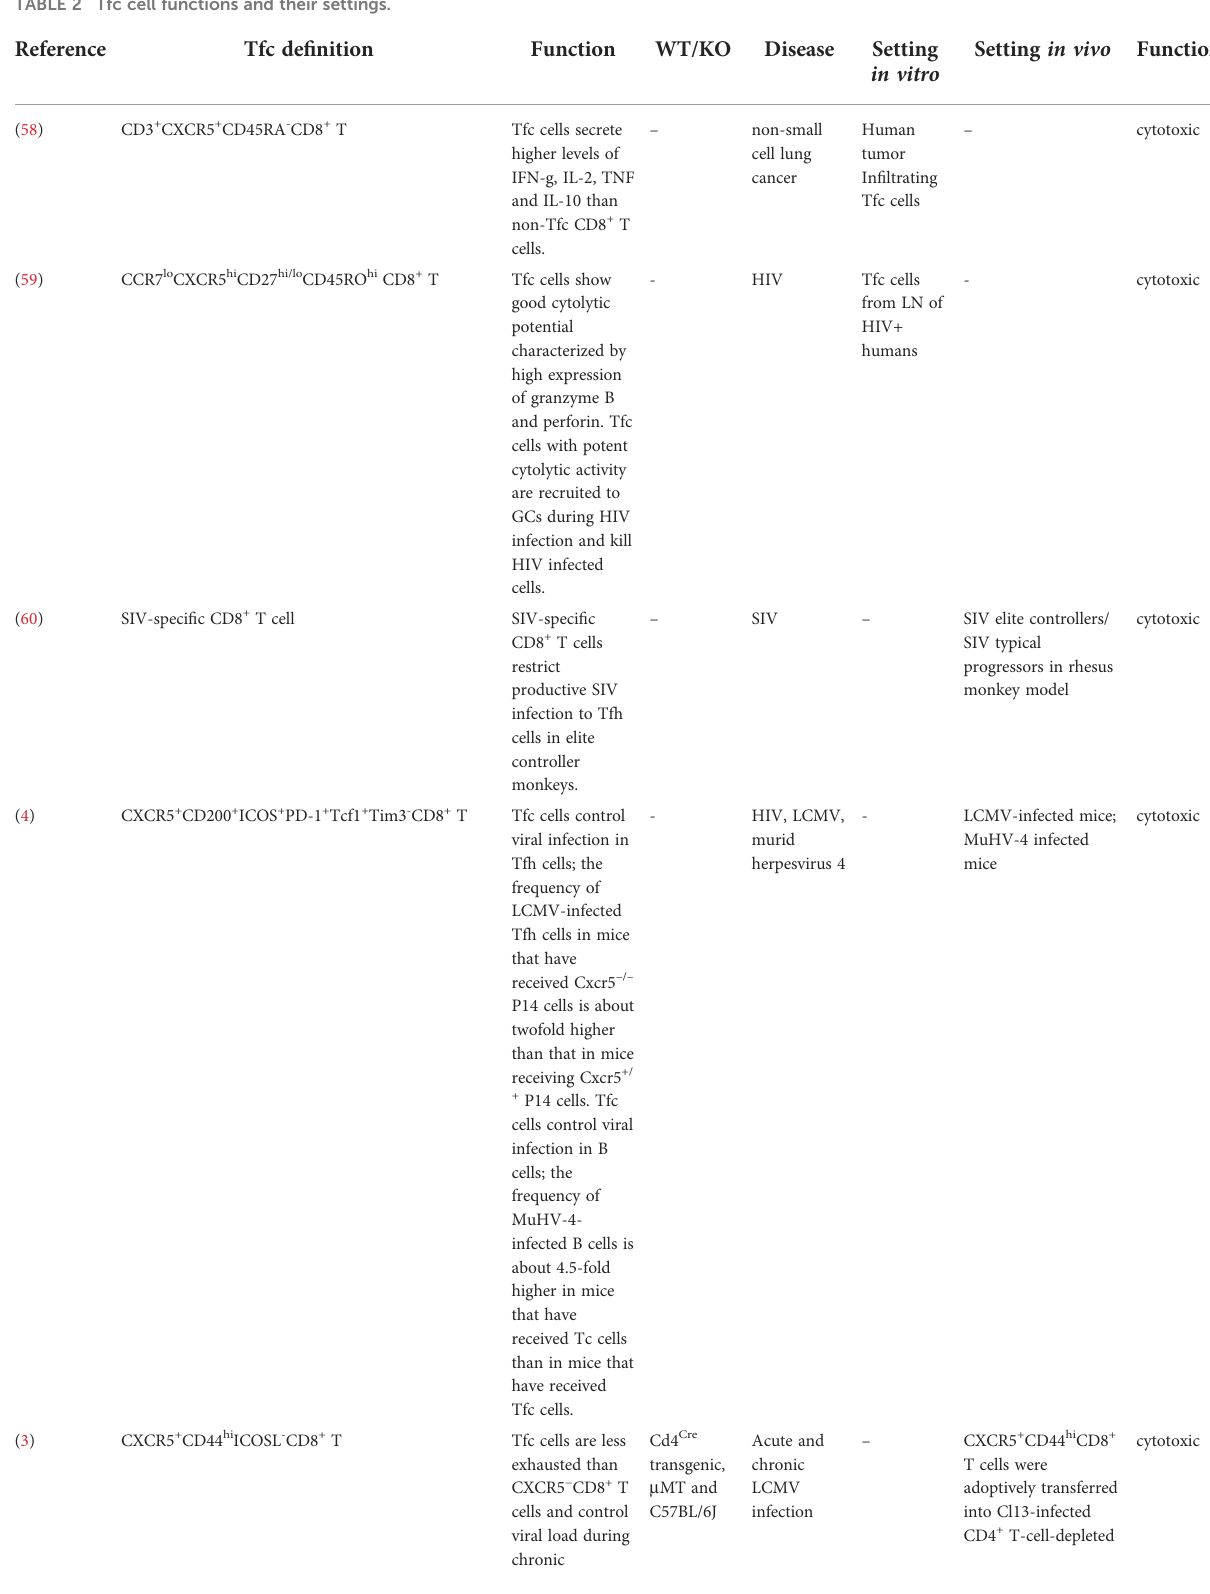
TABLE 2 Tfc cell functions and their